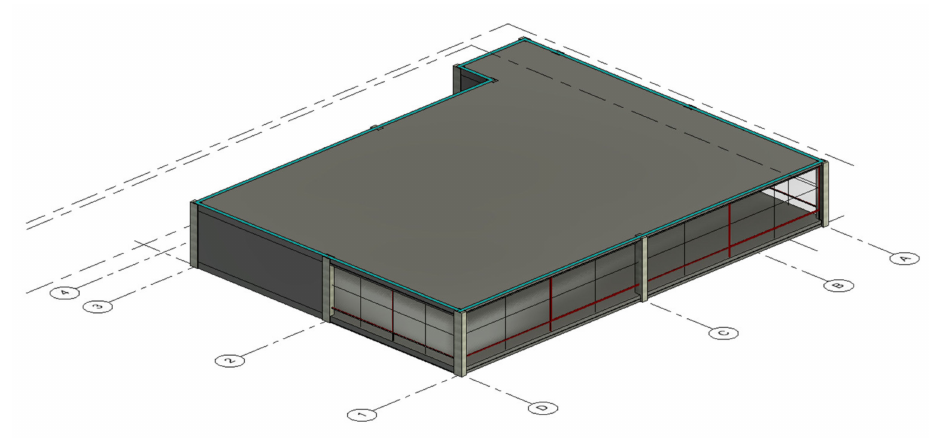
Figure A2. Case Study—L shape BIM